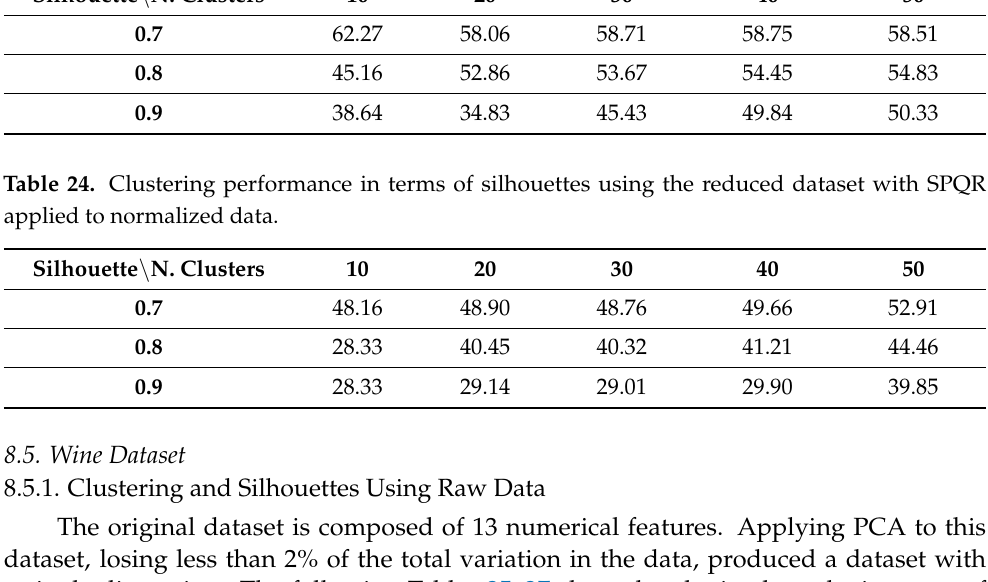
Table 23. Clustering performance in terms of silhouettes using the reduced dataset with PCA applied to normalized data. Silhouette \ N. Clusters